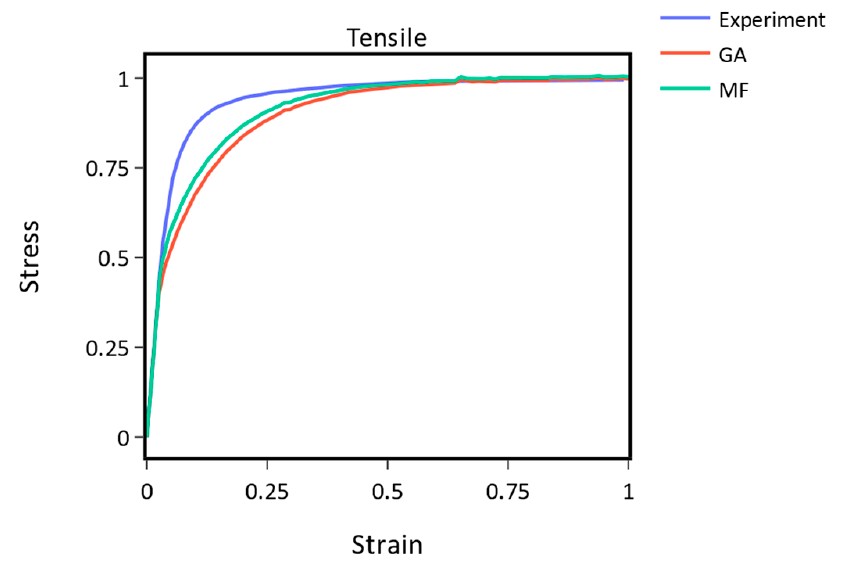
Figure 9. The GA and MF methods compared to the experimental tensile curve. The MF method outperforms the GA. outperforms the